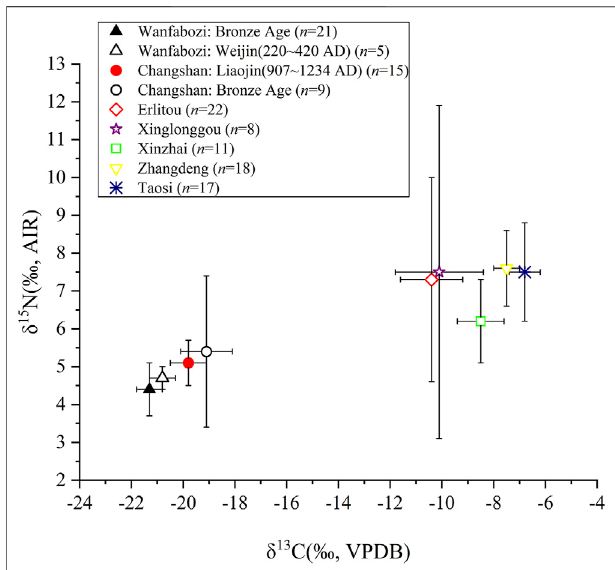
FIGURE 6 | Error bar chart for this study and previous published data in different region, China.